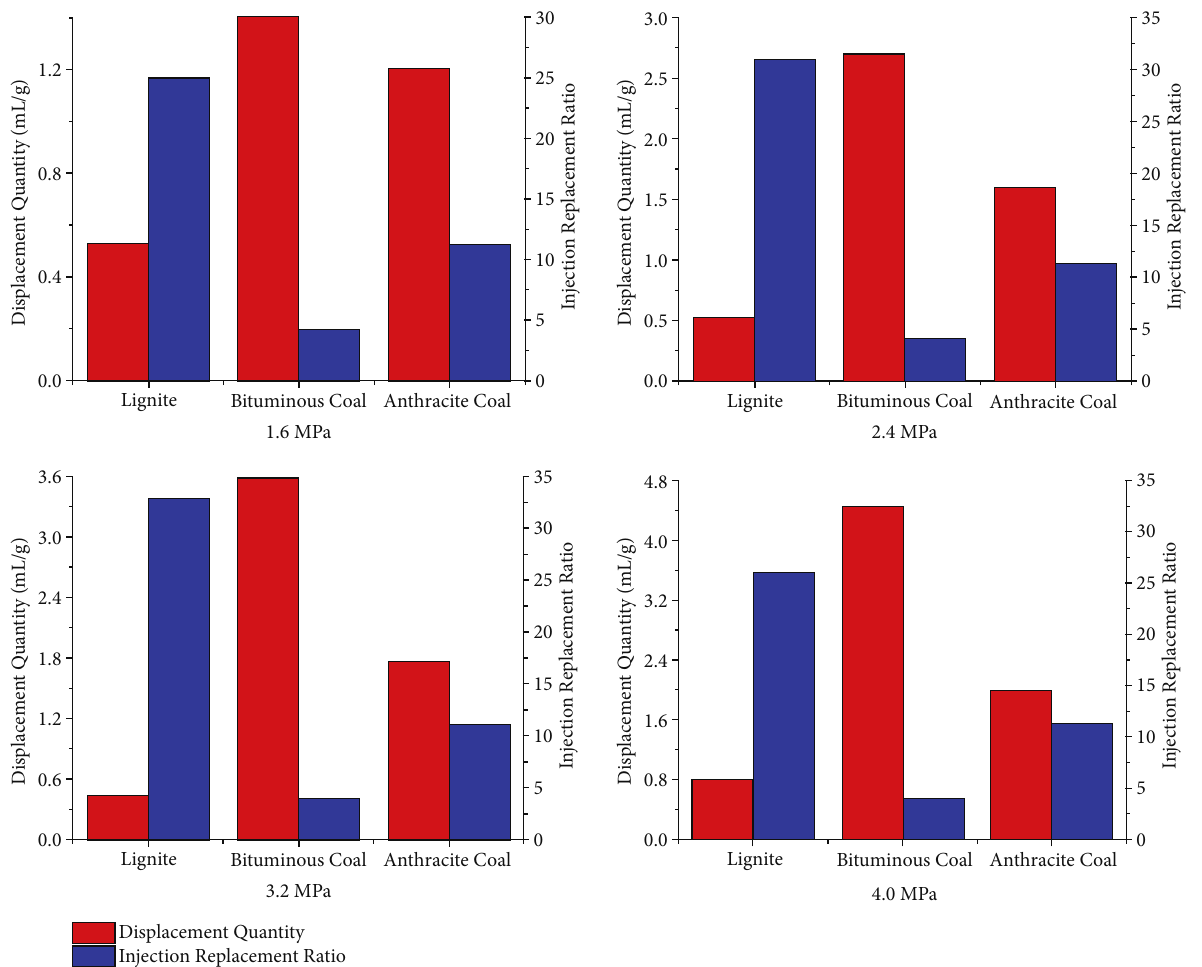
Figure 9: Displacement in lignite, bituminous coal, and